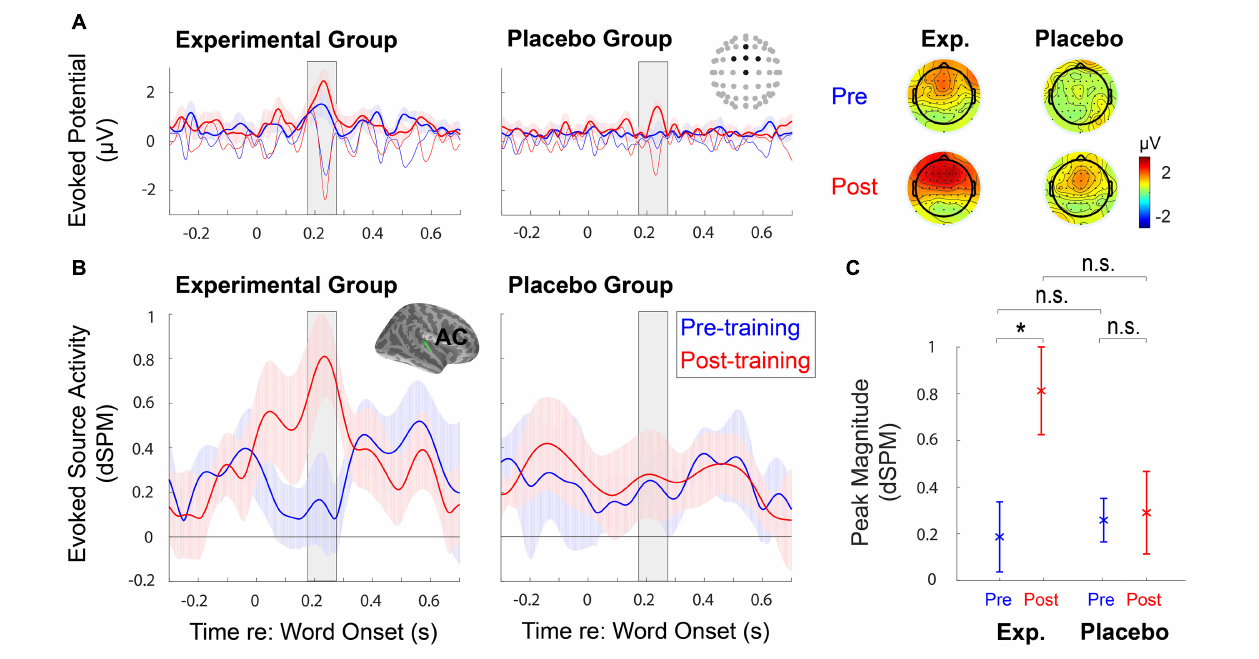
FIGURE 5 | (A) The mean time courses of evoked potentials and topographies elicited to word-in-noise are obtained at the sensor-space level during pre- and post-training speech-in-noise tests. Thin lines indicate raw evoked potentials, while thick lines represent the temporal envelope of those evoked potentials. (B) The region-of-interest-based source analysis shows the mean time courses of the temporal envelope of evoked source activity, with ± 1 standard error of the mean (SEM), obtained at the right auditory cortex (AC) during pre- and post-training speech-in-noise tests. (C) The comparison of the mean ( ± 1 SEM) peak magnitudes of the temporal envelopes. The peak magnitudes obtained at the right AC significantly differ before and after training in the Experimental Group. *Significant at p < 0.05, n.s., not